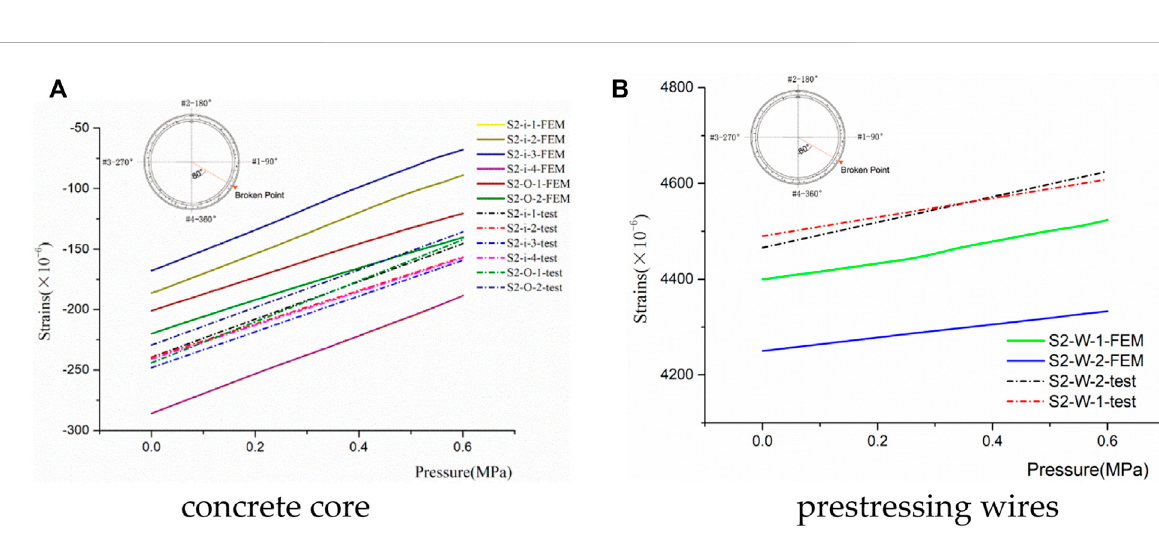
Frontiers in Earth